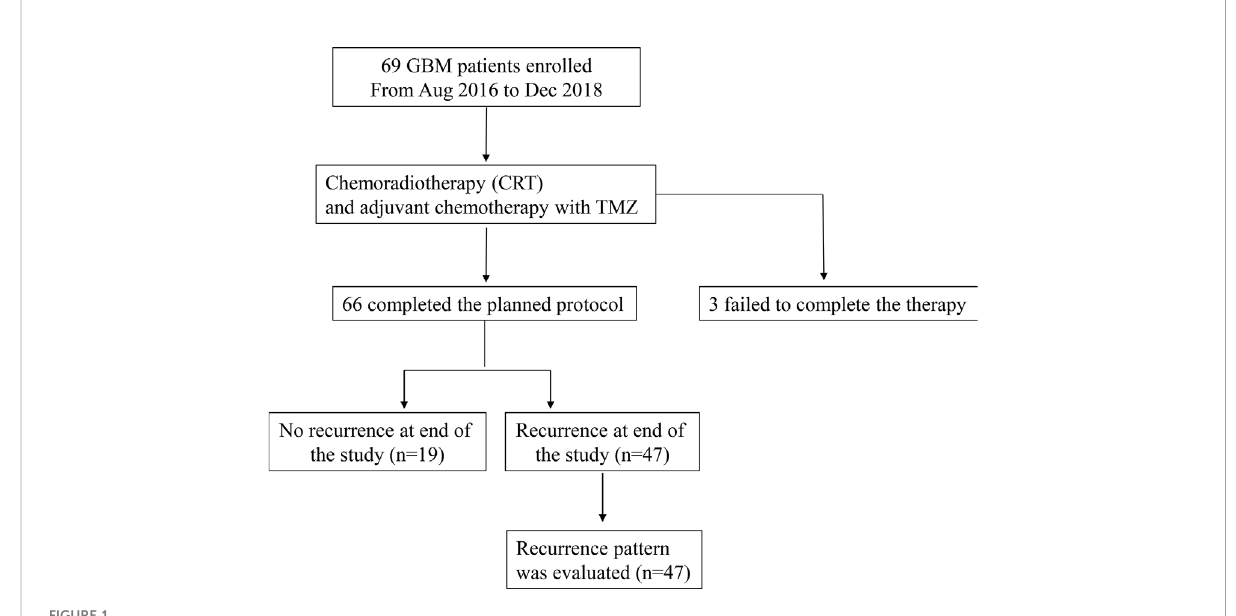
FIGURE 1 Flow chart of the study schema. GBM,